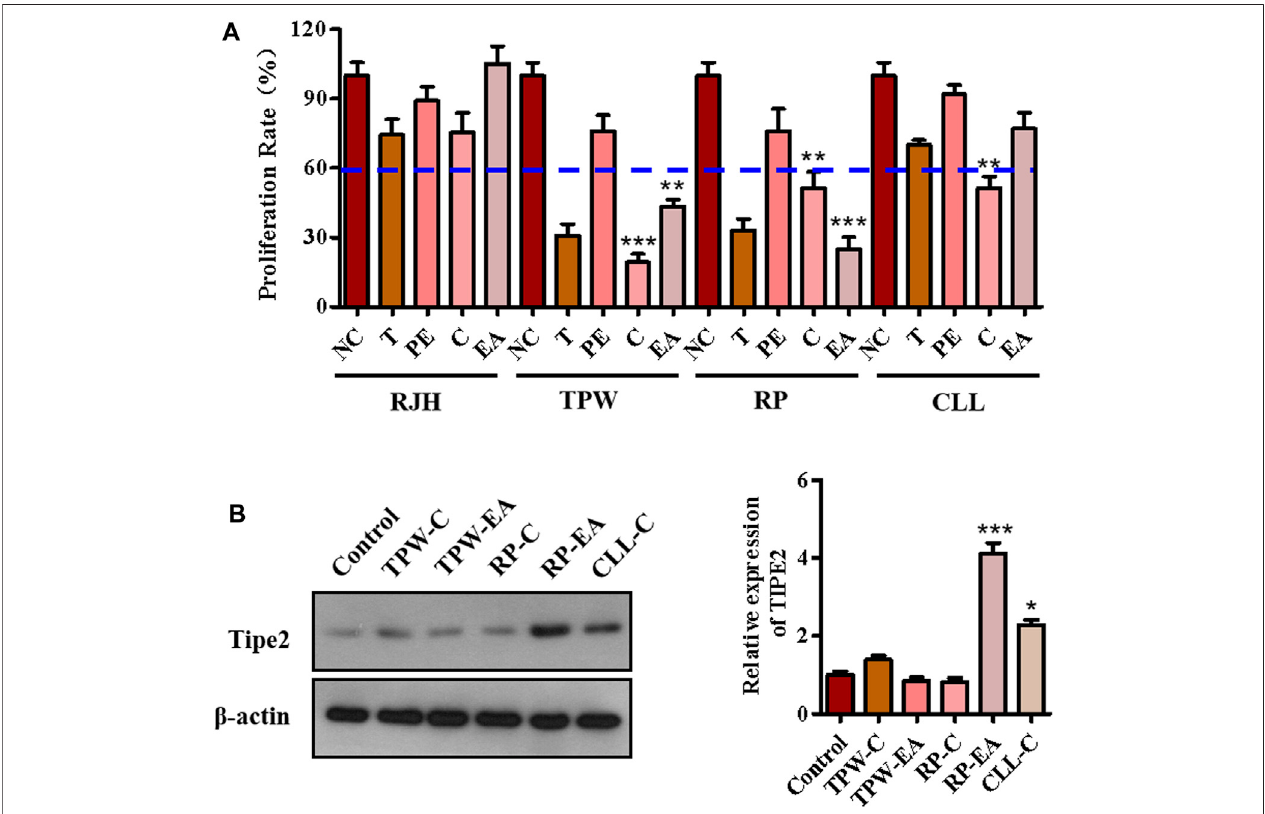
FIGURE 1 | The components analysis of active fractions from medicinal plants. (A) The effect of medicinal plants on cell proliferation in BGC823 cells. 50 μ g/ml extractions of the plants were used to treat BGC823 cells for 48 h. (B) The effects of active fractions on the expression of TIPE2. 50 μ g/ml active fractions were used to treat the BGC823 cells for 12 h. The values in the histogram are displayed as mean ± SD; 0.01 < p < 0.05 (*) represents a signi fi cant difference, and p < 0.001 (***) represents an extremely signi fi cant difference to the normal control.